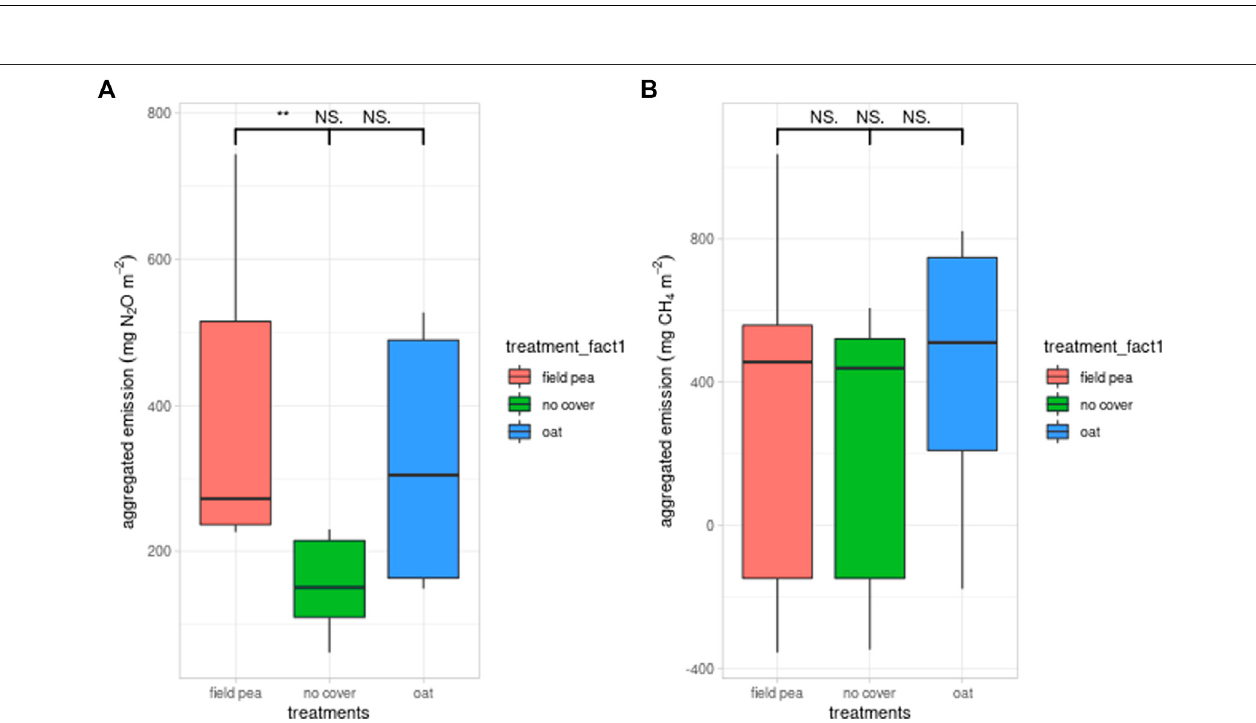
FIGURE 7 | Boxplots of the aggregated N 2 O (A) and CH 4 (B) exchange from CS10 by the diversi fi cation treatment; fi eld pea, no cover(control) and oats.